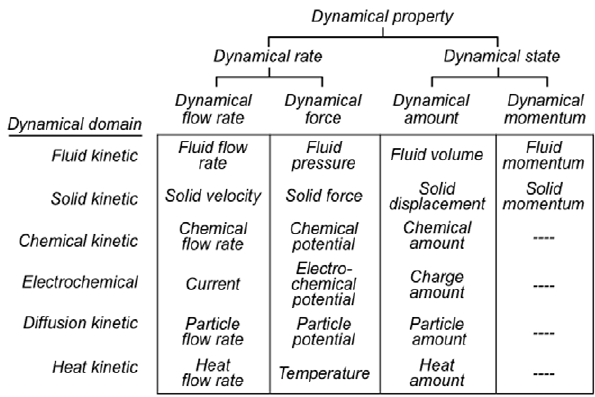
Figure 4. OPB: Dynamical property subclasses. Each subclass is cross-product of a one of four OPB: Dynamical property classes with one of the six OPB: Dynamical domain subclasses (except for OPB: Dynamical momentum